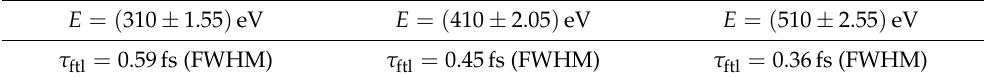
Table 1. Fourier-transform limit across the energy range of interest for a spectral bandwidth of 1.0%. E = ( 310 ± 1.55 ) eV E = ( 410 ± 2.05 ) eV E = ( 510 ± 2.55 ) eV τ ftl = 0.59fs (FWHM) τ ftl = 0.45fs (FWHM) τ ftl = 0.36fs